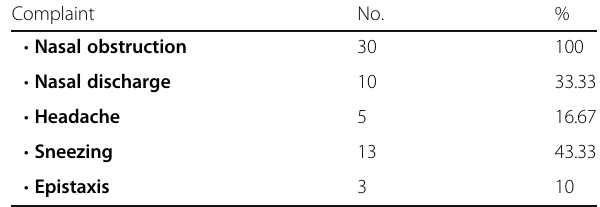
Table 1 Complaint and clinical presentation of